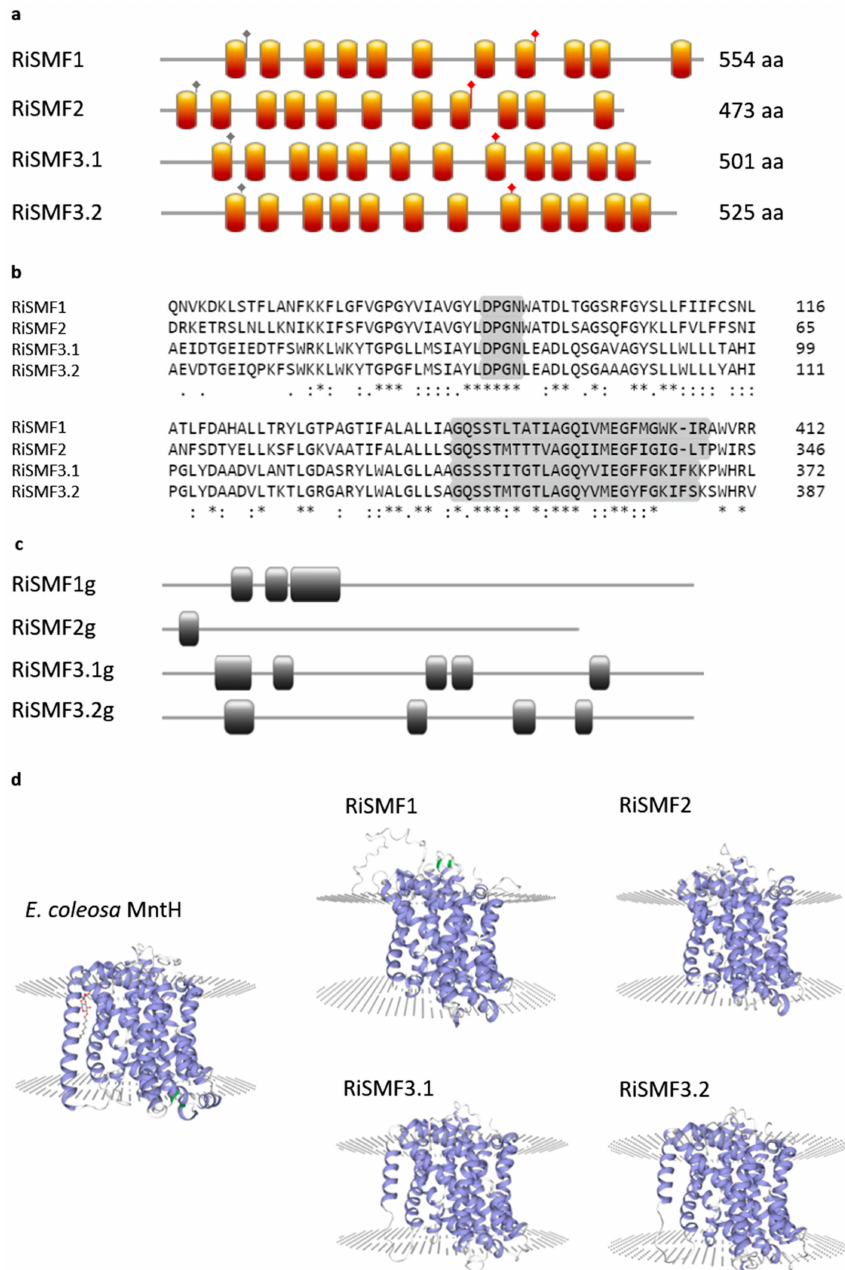
Figure 1. ( a ) Representation of the structure of R. irregularis NRAMP transporters. Orange boxes represent transmembrane domains, grey diamonds show the position of the DPGN motif and red diamonds show the position of consensus transport motif. ( b ) Multiple Sequence Alignment of the four protein sequences, with the DPGN and consensus transport motif highlighted. * indicates positions which have a single, fully conserved residue; indicates conservation between groups of strongly similar properties; indicates conservation between groups of weekly similar properties, ( c ) Exon/intron organization of RiSMF genes. Exons and introns are represented by grey lines and grey boxes, respectively. ( d ) Predicted 3D structure of RiSMF transporters. Tertiary structures were predicted by SWISS-MODEL software, based on the template of E. coleosa MntH (ID: 5m87.1A). α -helices and β -lamina are represented in blue and green,